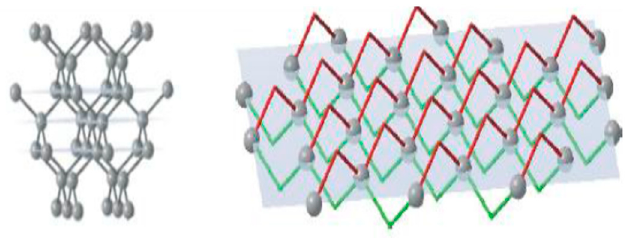
Figure 3. Atomic plane of cubic face.